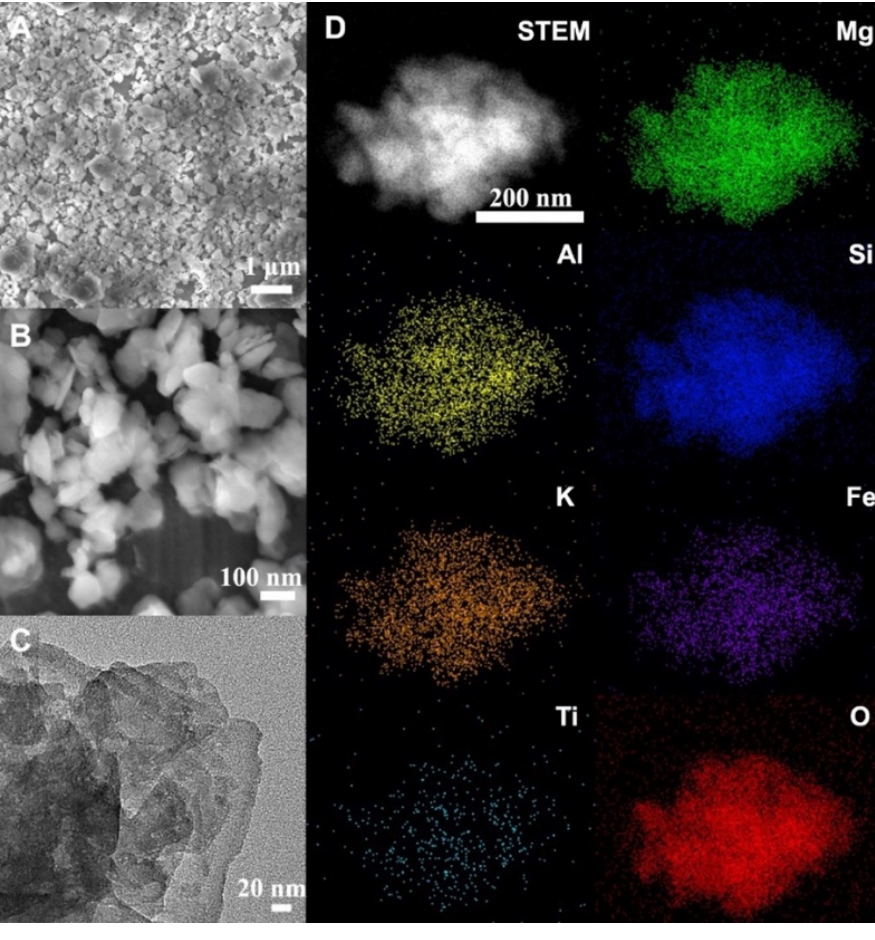
Figure 2. SEM ( A , B ), TEM ( C ) and EDS ( D ) elemental mapping images of SMV.